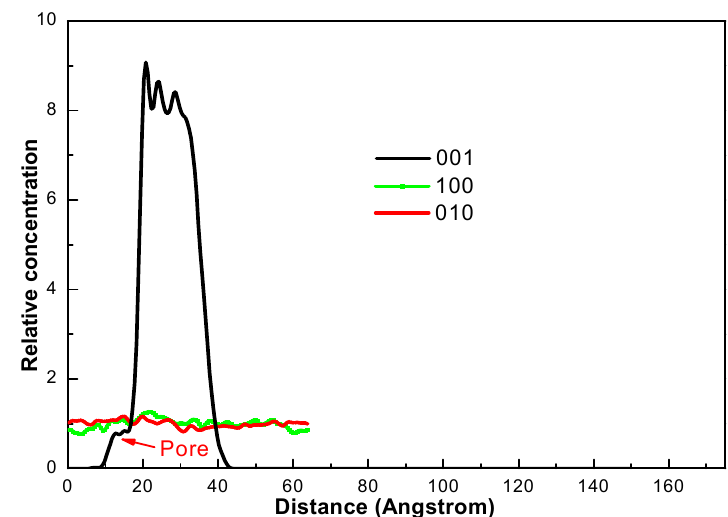
Figure 4. Final configuration of the coal-water (CW) system.